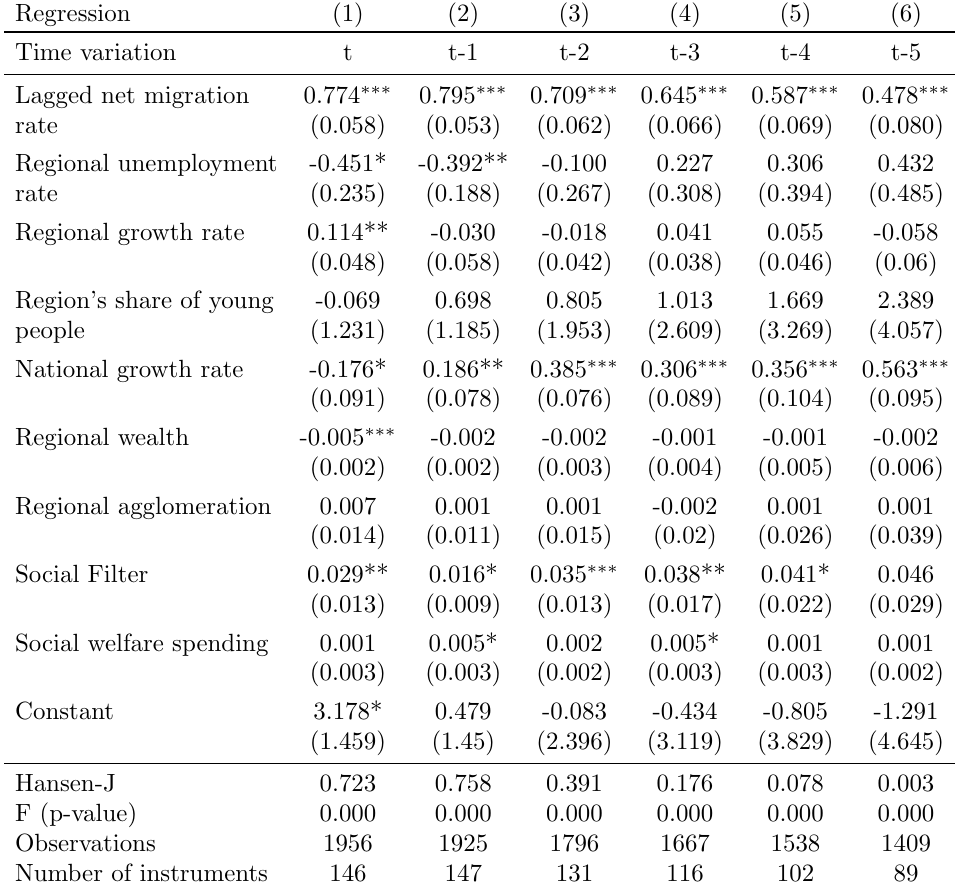
Table 1: EU-15: Regional net migration in the European Union: Dynamic panel data